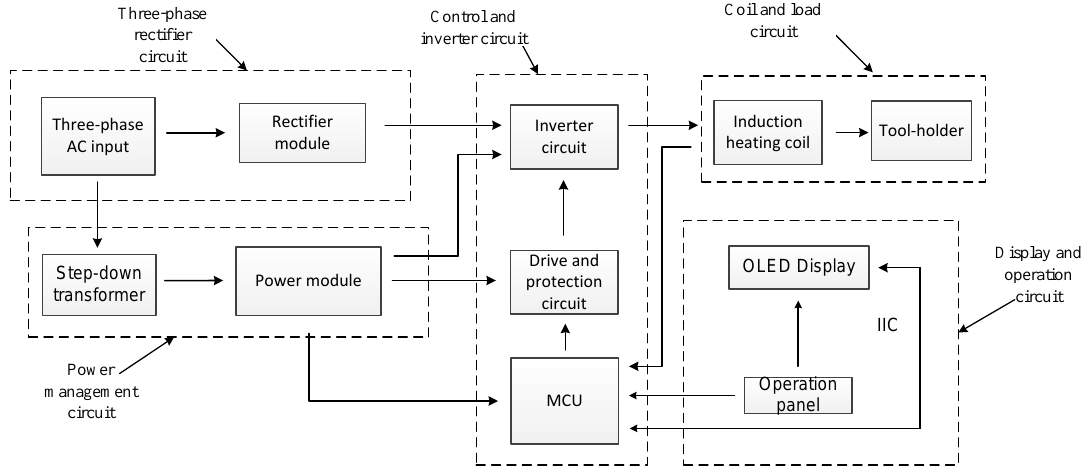
Figure 10. Overall circuit framework of tool holder heat-loading equipment.